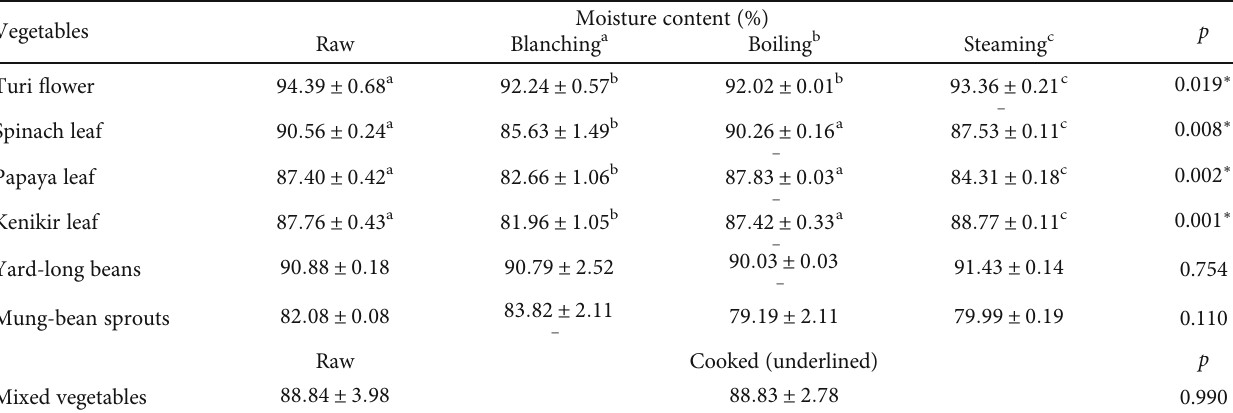
Table 1: E ff ect of cooking methods on the moisture content of cooked Pecel vegetables. Vegetables